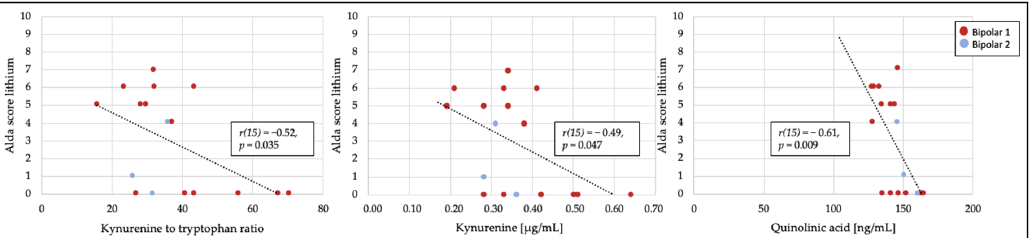
Figure 2. Significant correlations of the Alda score of lithium response to kynurenine/tryptophan ratio, kynurenine, and quinolinic acid . ratio, kynurenine, and quinolinic